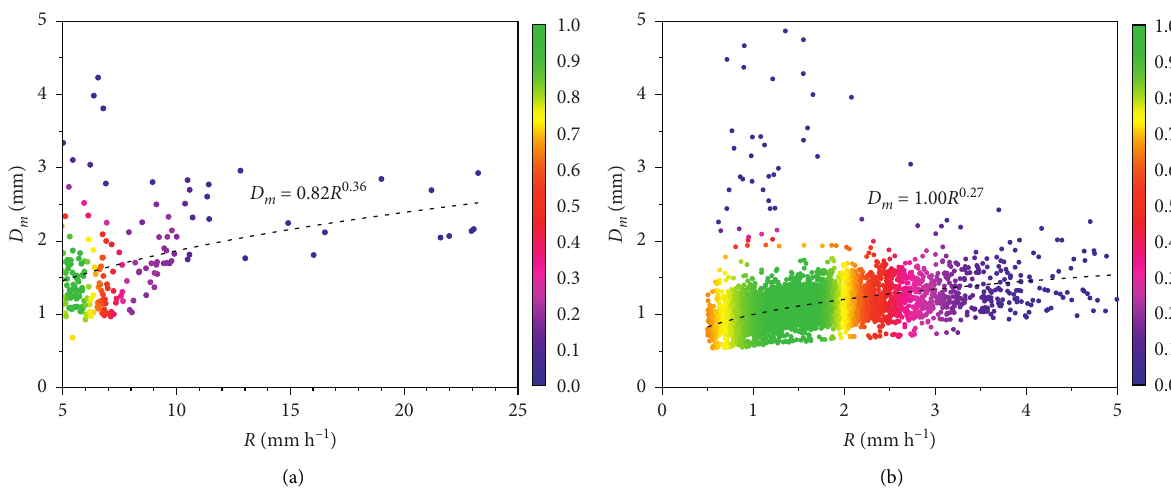
Figure 5: Scatter density plot for D R (mm · h − 1 ) for convective rainfall. (a) And stratiform rainfall (b). The fitted relationships m (mm) and are also provided in each panel adopting a least-squares method, and the color bar represents the relative density of scattered